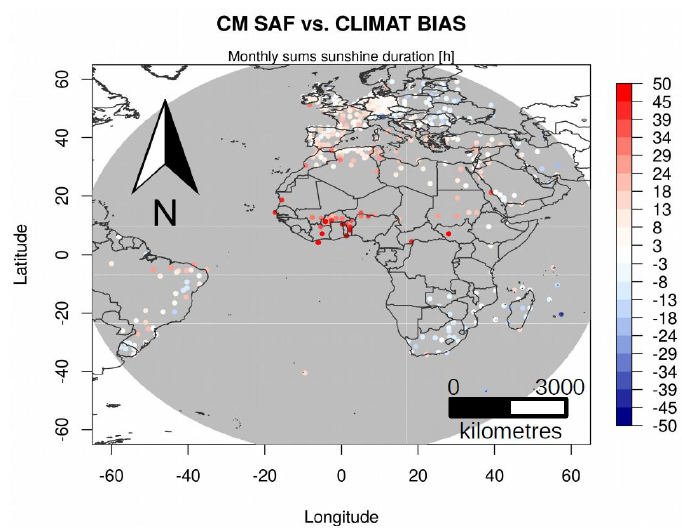
Figure 5. Spatial distribution of the bias (h) between monthly SDU and CLIMAT for the time period 1983 to 2015.